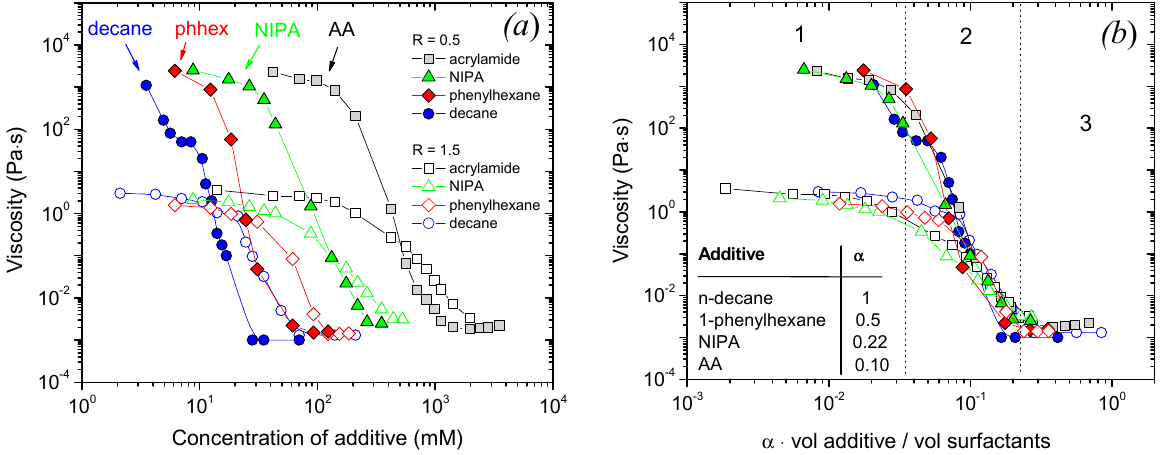
Figure 2. Dependences of zero-shear viscosity on additive concentration ( a ) or on volume ratio α · (vol. additive)/(vol. surfactant) ( b ) for aqueous solutions containing 78 mM potassium oleate, 39 mM (filled symbols) or 117 mM (open symbols) C8TAB and different additives: acrylamide AA (squares), n-isopropylacrylamide NIPA (triangles), 1-phenylhexane (diamonds), n-decane (circles). Temperature: 200C, pH 11. In Figure 2a, the curves for n-decane are reproduced with permission from